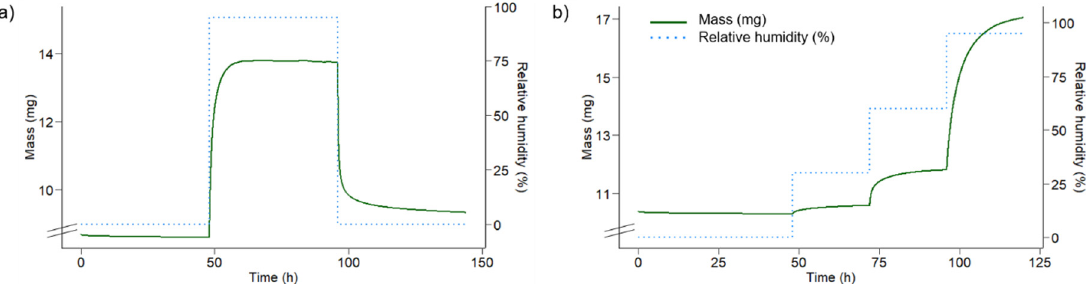
Figure 8. Sorption behaviour of pure SCA polymer. ( a ) Deuterium exchange experiment; ( b ) adsorption isotherm; Both measurements conducted at 25 °C. The solid green line shows sample mass and the dotted blue line shows relative humidity. Note the secondary y -axis and the broken primary y -axis.